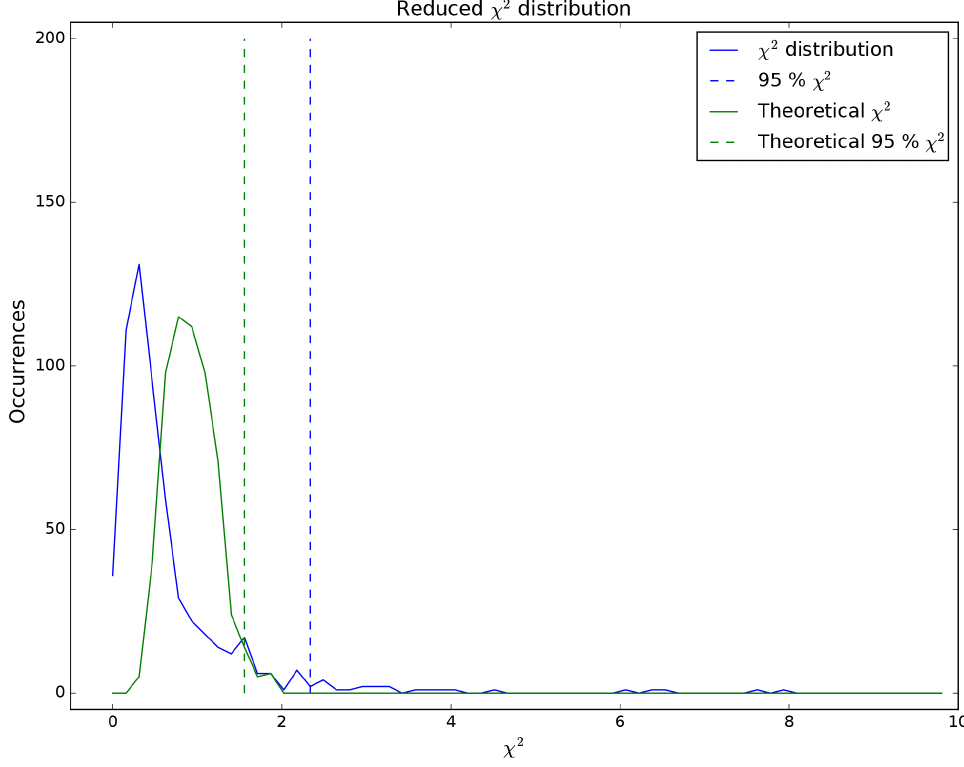
midity, satisfying, on average, the consistency check (Eq. 1) for night-time